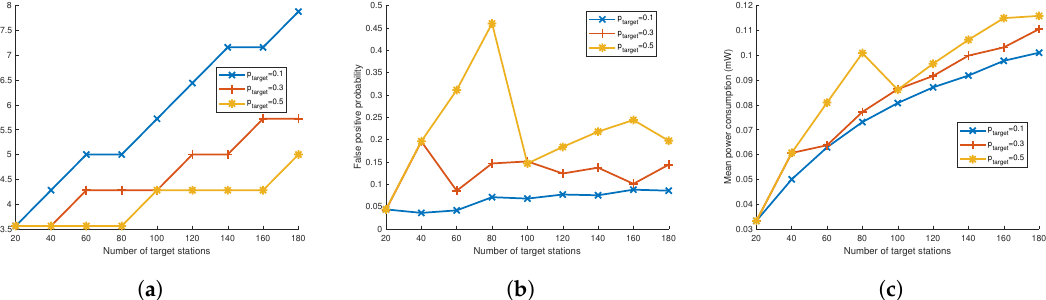
Figure 10. ( a ) Expected wake-up delay, ( b ) false positive probability and ( c ) mean power consumption for p target = 0.1, 0.3, and 0.5 for Bloom